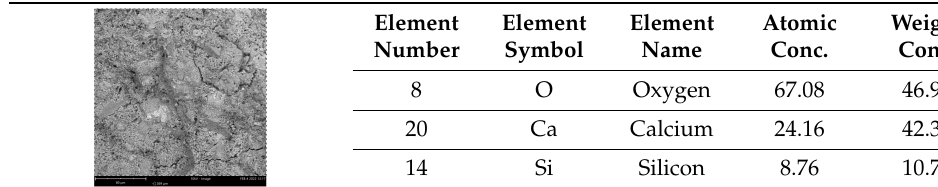
Table 12. SEM-EDS result for Y 1 concrete sample spot 1.